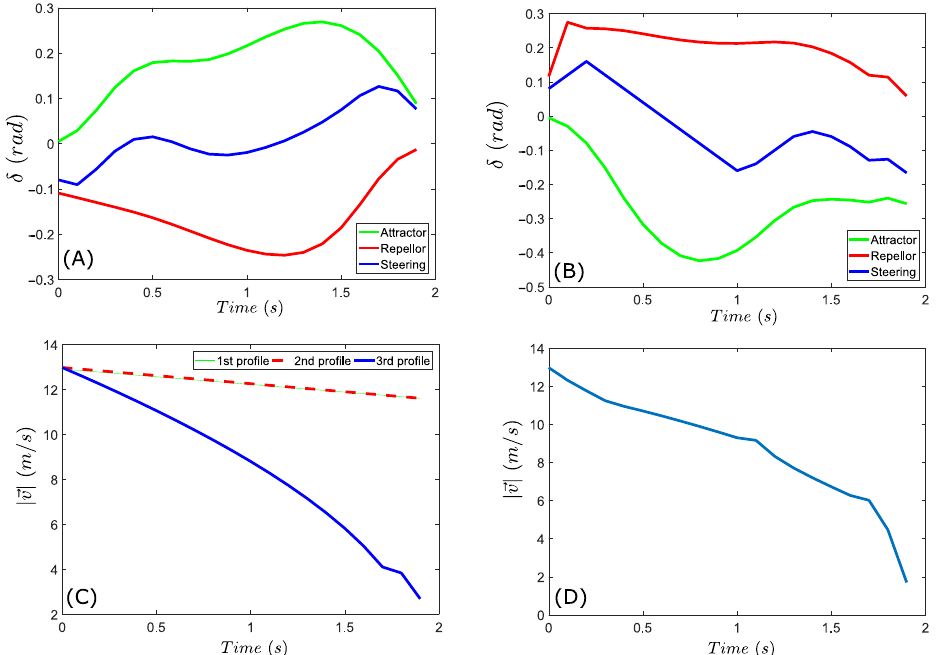
Figure 11. ( A ) Resulting steering angle calculated for blue trajectory. ( B ) Resulting steering angle calculated for magenta trajectory. ( C ) Velocity profile for each generated trajectory. ( D ) Resulting velocity profile for the first to final